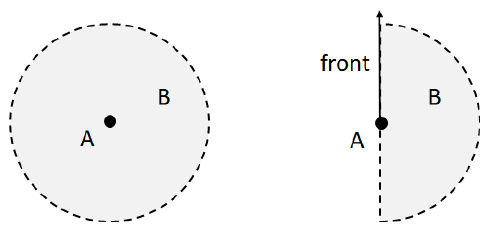
Figure 9. Search space of place B for relationship < B , right of , A > without a reference direction ( left ) compared to with anchored reference direction information ( right ).